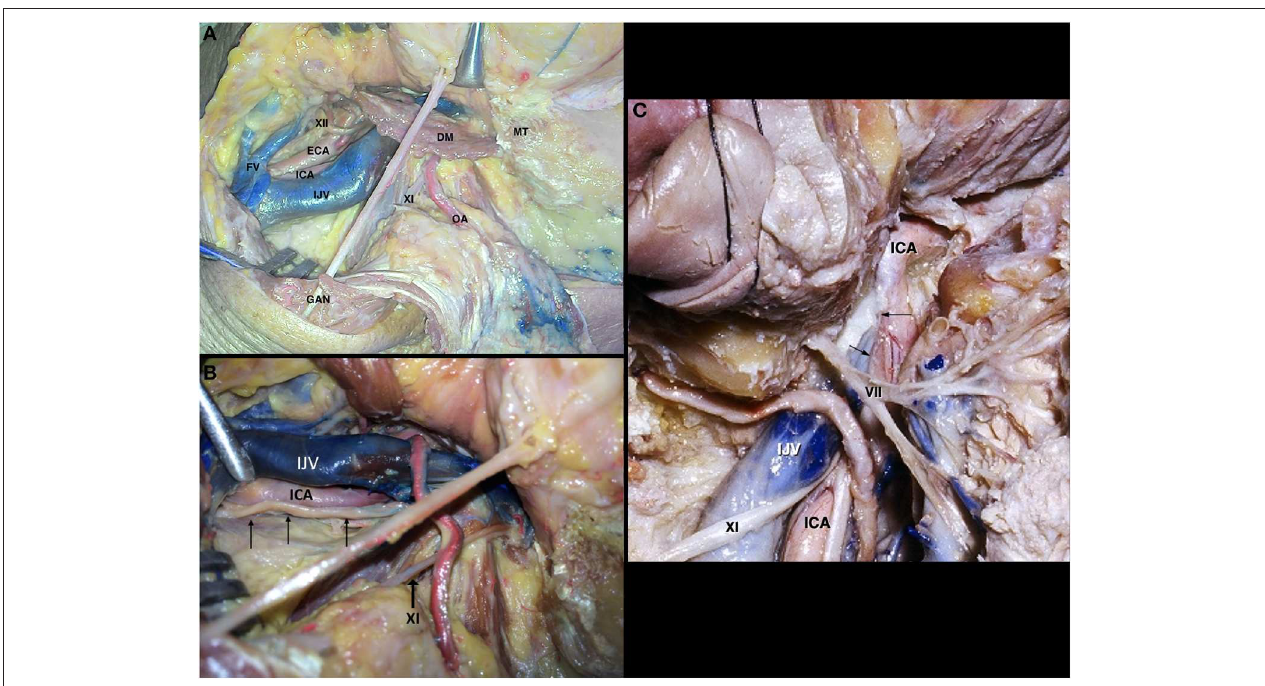
FIGURE 9 | Neck dissection [Modified from Ramina and Tatagiba (3)]. (A) Exposition of the skull base and vascular structures. (B) Course of the vagus nerve in the proximal cervical region (arrows). (C) Relationship of the carotid artery and venous system on the lateral skull base. Arrows represent the space between both structures where the glossopharyngeal, vagus, and accessory nerves exit the skull base. DM, digastric muscle; ECA, external carotid artery; FV, facial vein; GAN, great auricular nerve; ICA, internal carotid artery; IJV, internal jugular vein; MT, mastoid tip; OA, occipital artery; VII, facial nerve; XI, accessory nerve; XII, hypoglossal